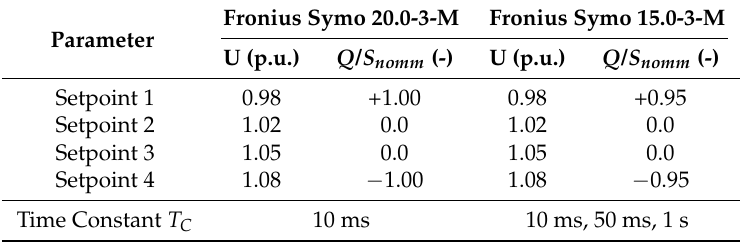
Table 4. Overview of the implemented step points parameterised for the